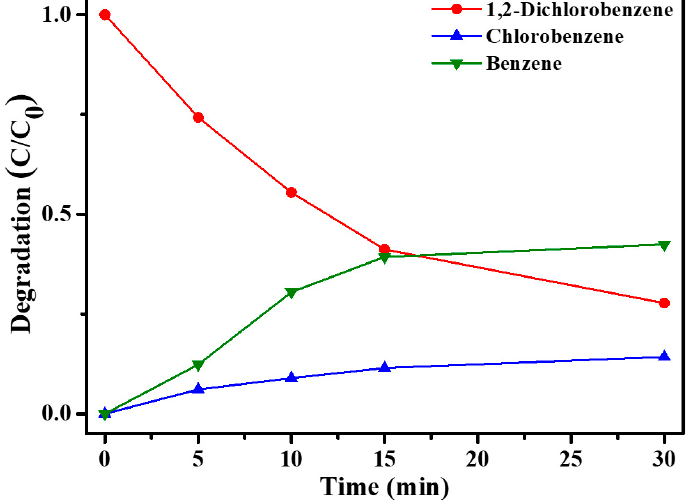
Figure 5. Plot of degradation ratio of 1,2-DCB ( ) and formation of chlorobenzene ( (cid:78) ) and benzene ( (cid:72) ) versus the reaction time for the dechlorination reaction of 1,2-DCB with the sample of 24.29 wt.% of Pd loading onto Ni